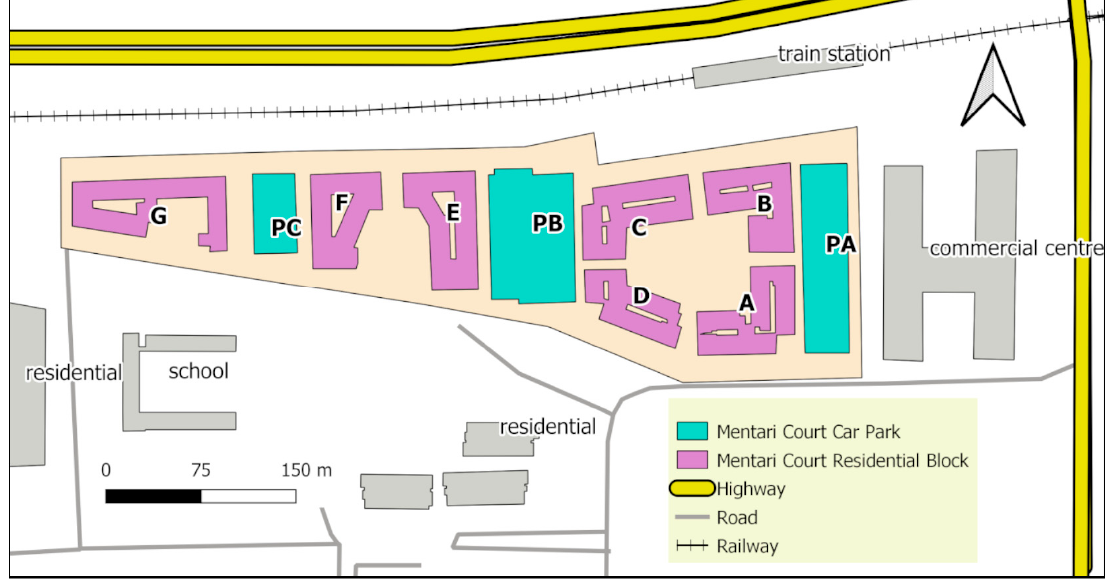
Figure 1. Map of Mentari Court; Block A, B, C, D, E, F & G are residential blocks; Block PA, PB and PC are car parks blocks.